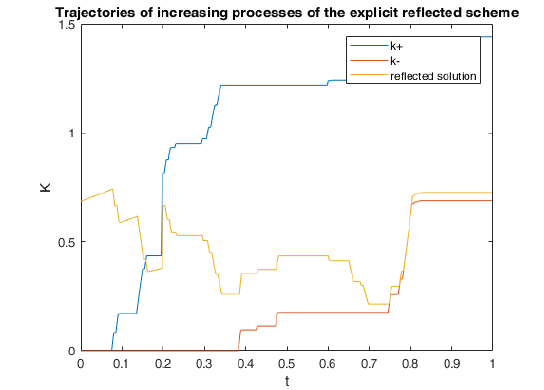
Figure 9. One path of Y π , α in the explicit reflected scheme ( τ = 0.2).